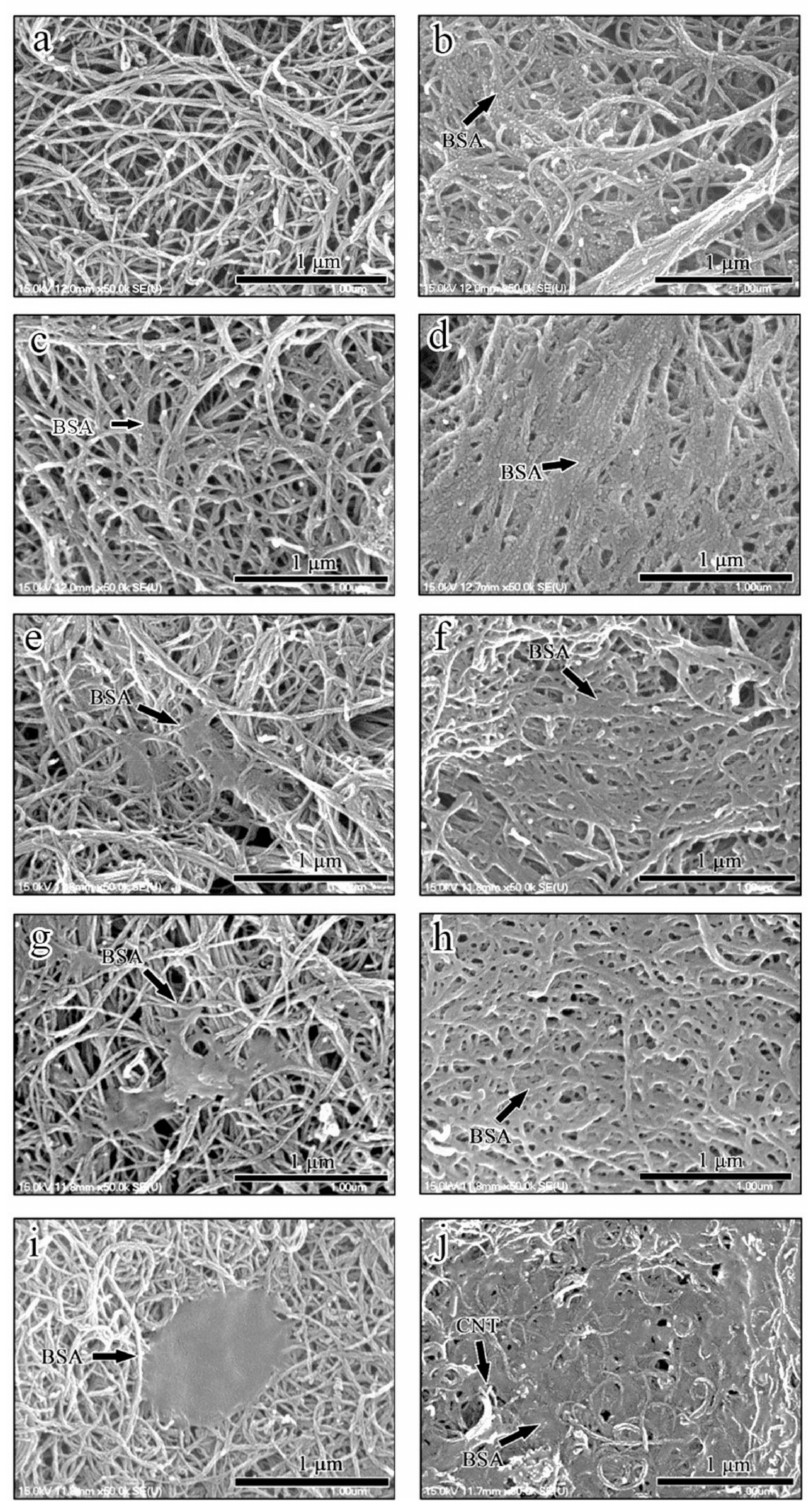
Figure 8. Microstructure of various specimens after adding two different concentrations (100 ng/mL and 100,000 ng/mL) of BSA. ( a ) S–BP, 100 ng/mL; ( b ) S–BP, 100,000 ng/mL; ( c ) S–BP–EDC/NHS, 100 ng/mL; ( d ) S–BP–EDC/NHS, 100,000 ng/mL; ( e ) S–BP–PSS, 100 ng/mL; ( f )